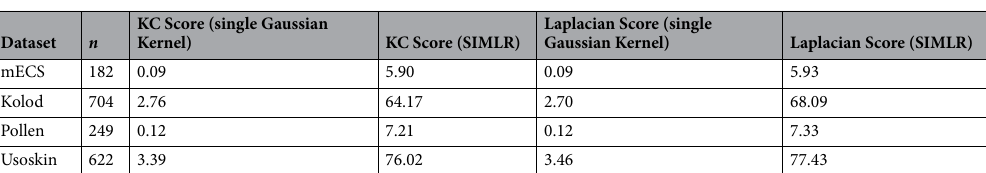
Figure 5. Three 2-dimensional latent spaces obtained by t-SNE for the Usoskin dataset: ( a ) Z Z S ( X ) . Z G ( V ∗ 55 ) , and ( c )